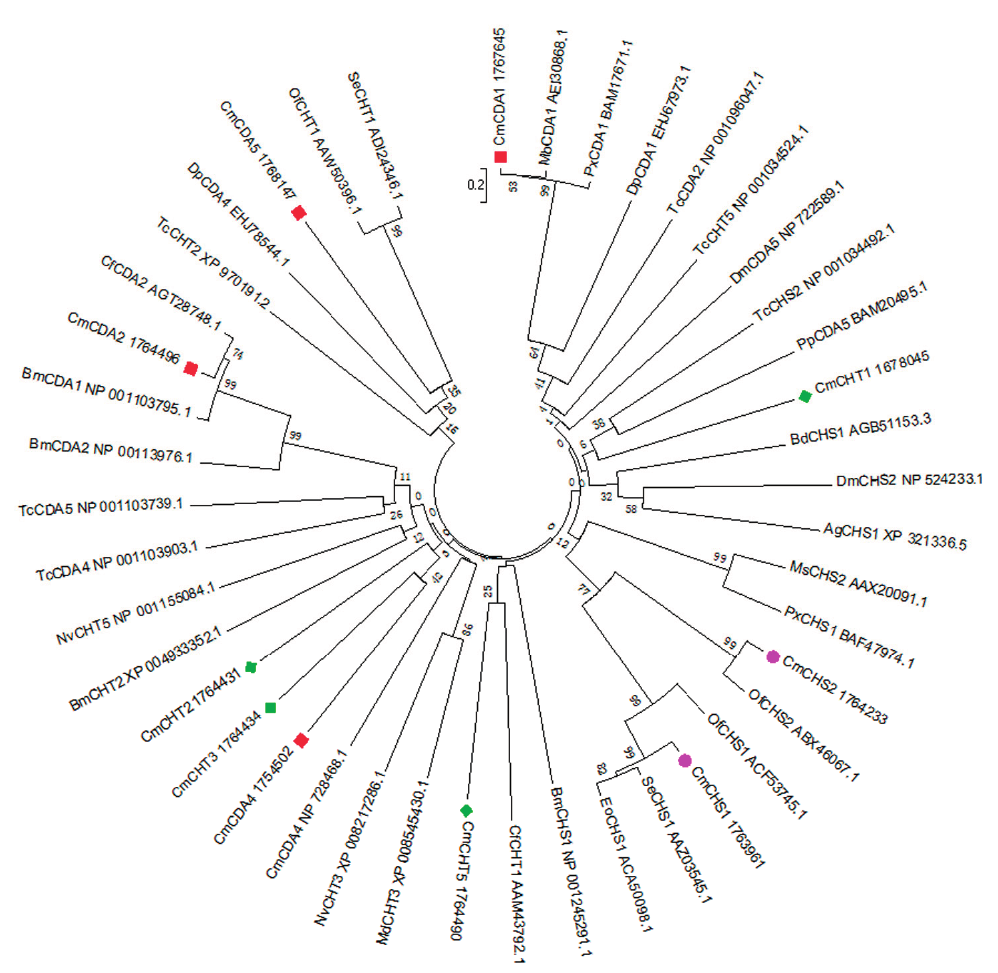
Figure 4. Phylogenetic relationships of chitin-related enzymes deduced from the open reading frame (ORF) among C. medinalis and other insect species. The tree was constructed from the multiple alignments using MEGA 6.0 program (1000 bootstrap replications). Bootstrap values >50% are shown. The C. medinalis enzymes are indicated by red, green or pink markers. Cm, Cnaphalocrocis medinalis ; Bm, Bombyx mori ; Of, Ostrinia furnacalis ; Px, Plutella xylostella ; Se, Spodoptera exiqua ; Eo, Ectropis oblique ; Ms, Manduca sexta ; Ag, Anopheles gambiae ; Dm, Drosophila melanogaster ; Bd, Bactrocera dorsalis ; Tc, Tribolium castaneum ; Mb, Mamestra brassicae ; Dp, Danaus plexippus ; Cf, Choristoneura fumiferana ; Nv, Nasonia vitripennis ; Md, Microplitis demolitor ; Px, Papilio xuthus ; Pp, Papilio